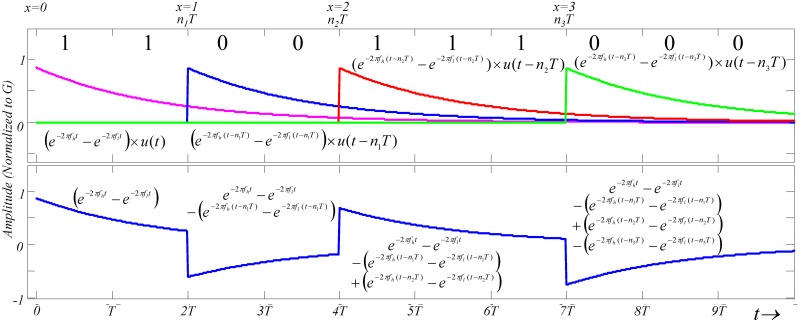
Diagram of a random digital signal transmitted through a band-limitted channel Eq 12.